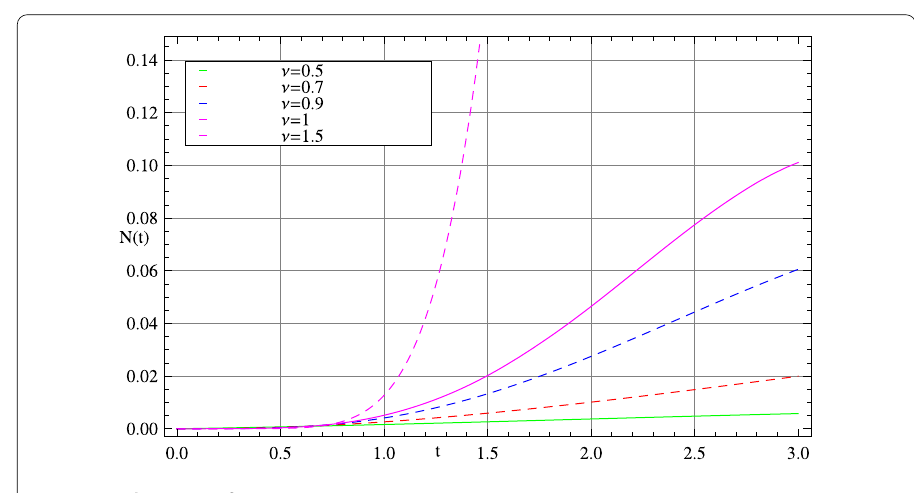
Figure 2 Solution (22) for N ( t ), k = 2.